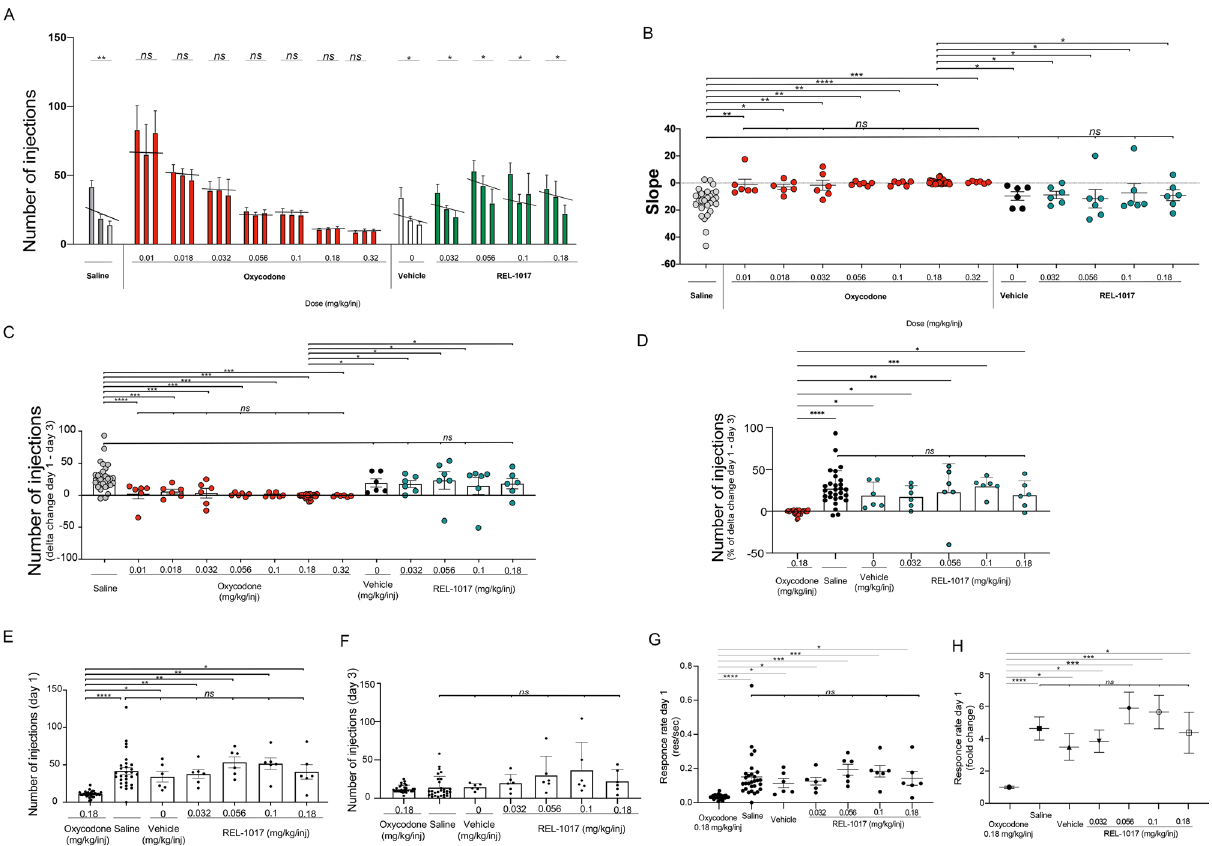
Figure 3. Self-administration of REL-1017 in rats previously trained to administer oxycodone in 3-day substitution study. ( A ) Drugs were self-administered via intravenous (IV) bolus injections utilizing the surgically implanted venous catheters connected to a Med-PC computer system. Injection requirement was FR10 (10 lever presses = 1 injection). Trained rats were tested with saline control (n = 29, gray bars) or with the 0.18 mg/kg/injection training/ maintenance dose of oxycodone (n = 29). Following the establishment of oxycodone as a reinforcer, 6 rats per each treatment were tested with the positive control substance (0.01, 0.018, 0.032, 0.056, 0.10, and 0.32 mg/kg/injection oxycodone; red bars), and/or REL-1017 (0, 0.032, 0.056, 0.10, and 0.18 mg/kg/injection; green bars). Each group of 3 bars represents the results for Days 1, 2, and 3. Each bar represents the mean of ≥ 6 rats. All positive control groups exposed to any oxycodone dose maintained a stable number of infusions over 3 days (p = ns between injections at day 1 and 3 for all dosing groups). As expected for non-reinforcing stimuli in this experiment, saline, vehicle, and all REL-1017 doses showed a typical “extinction burst” pattern of responding, characterized by an initial rapid increase of lever-pressing on the first day followed by a downward staircase pattern of responses on the second and third day (*p < 0.05, **p < 0.01 between injections at day 1 and 3). ( B ) Comparison of the number of injections at day 1. ( C ) Comparison of the number of injections at day 3. ( D ) Delta changes between the injection number at day 1–3. ( E ) Percent of delta changes between the injection number at day 1–3. REL-1017 at all tested doses showed a pattern comparable to vehicle and saline. For each condition, the differences in the day-to-day pattern of injection during the test session and the linear regression functions (slopes) fitted to the total number of injections during each three- day interval calculated for each study item is shown in ( F ). The calculated slopes for saline (gray dots), vehicle (black dots), and REL-1017 at all doses (green dots) were not statistically different between each other. The calculated slopes for saline, vehicle, and REL-1017 at all doses were all statistically significantly different when compared to oxycodone (red dots; *p < 0.05; **p < 0.01; ***p < 0.001; ****p < 0.0001). All 4 doses of REL-1017 tested in this study demonstrated a downward staircase pattern resulting in negative sloped linear functions (saline = − 13.83; vehicle = − 9.667; RE-1017 0.032 mg/kg/injection = − 8.833; REL-1017 0.056 mg/kg/injection = − 11.67; REL-1017 0.1 mg/kg/ injection = − 7.333; REL-1017 0.18 mg/kg/injection = − 9.083). All seven tested doses of oxycodone demonstrated a stable pattern resulting in neutral sloped functions (oxycodone 0.01 mg/kg/injection = − 1.083; oxycodone 0.018 mg/ kg/injection = − 2.917; oxycodone 0.032 mg/kg/injection = − 1.667; oxycodone 0.056 mg/kg/injection = − 0.5833; oxycodone 0.1 mg/kg/injection = − 0.3333; oxycodone 0.18 mg/kg/injection = 0.569; oxycodone 0.32 mg/kg/ injection = 0.5). ( G ) High rates of responding throughout the test sessions (responses/second) were observed in rats treated with saline (gray dots) and all doses of REL-1017 (green dots). The response rates for REL-21017 tested were significantly different from oxycodone (0.18 mg/kg/injection, red dots). ( H ) In particular, compared to the response rates for oxycodone 0.18 mg/kg/injection, saline had a 4.6-fold increase (p < 0.0001), REL-1017 vehicle had a 3.5-fold increase (p < 0.05), REL-1017 (0.032 mg/kg/injection) had a 3.8-fold increase (p < 0.001), REL-1017 (0.056 mg/kg/ injection) had a 5.9-fold increase (p < 0.05), REL-1017 (0.1 mg/kg/injection) had a 5.6-fold increase (p < 0.05), and REL-1017 (0.18 mg/kg/injection) had a 4.4-fold increase (p <